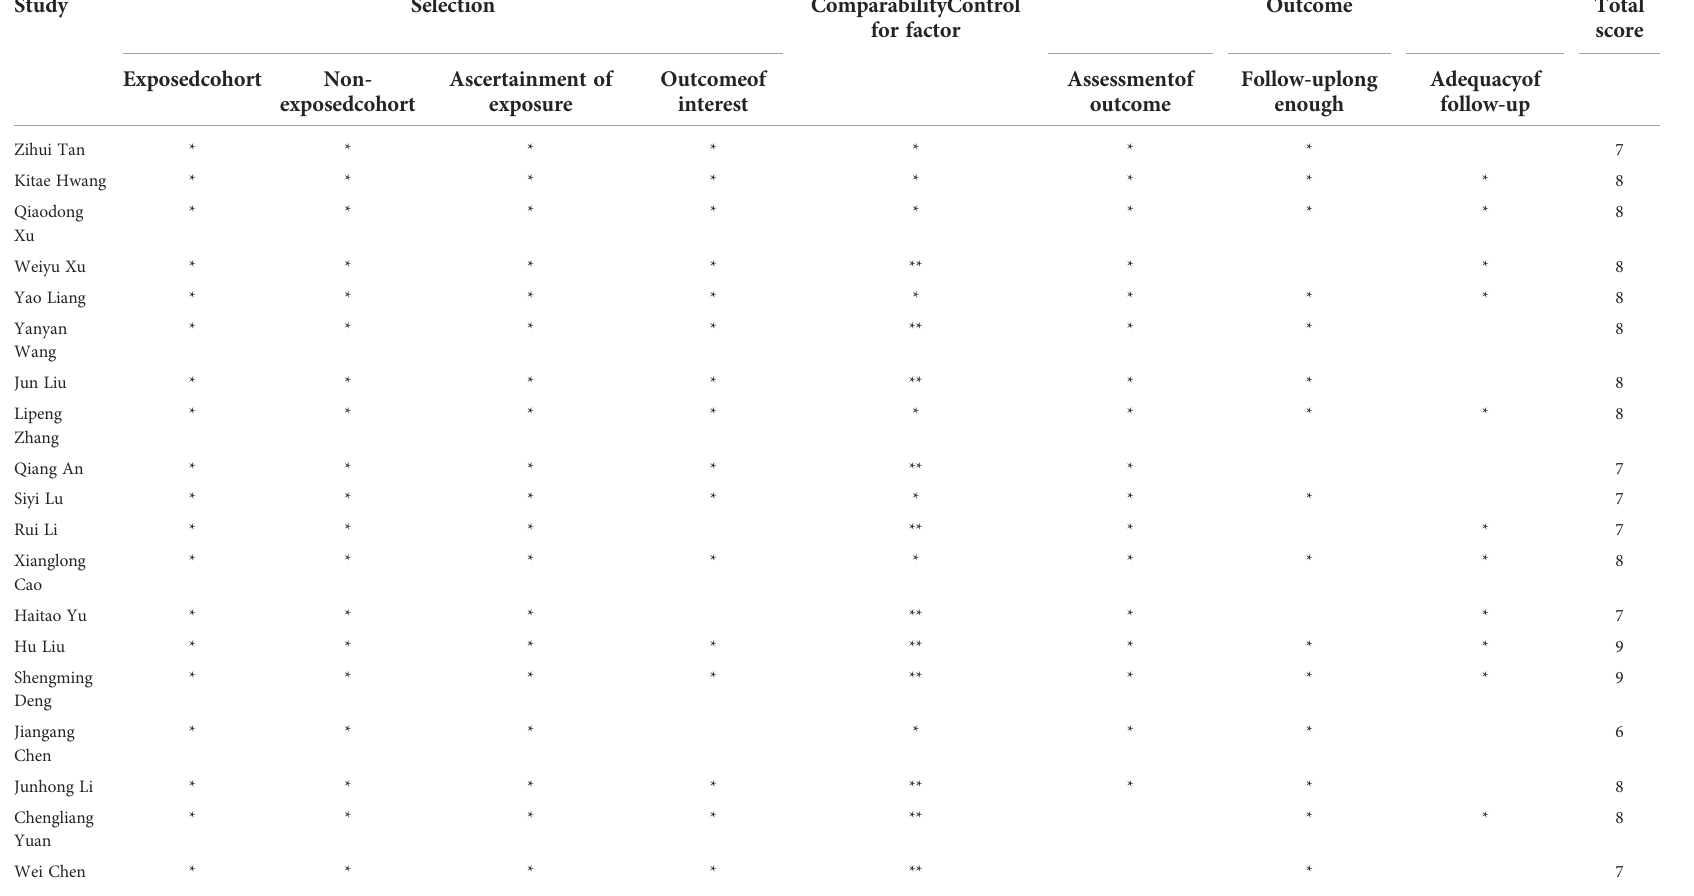
TABLE 2 Newcastle – Ottawa scale for quality